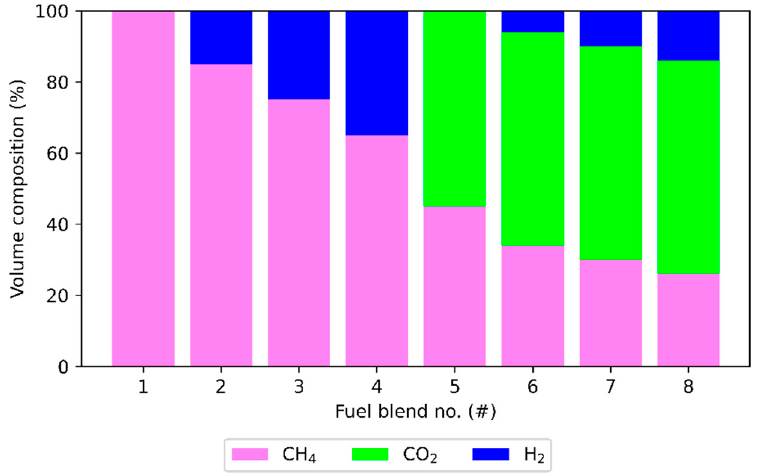
Figure 1. Volumetric composition of the test fuels in terms of methane, carbon dioxide, and hydro- gen.